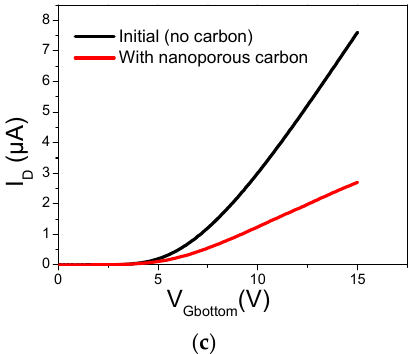
Figure 5 . Nanoporous carbon on active layer: ( a , b ) SEM images; ( c ) effect on transfer